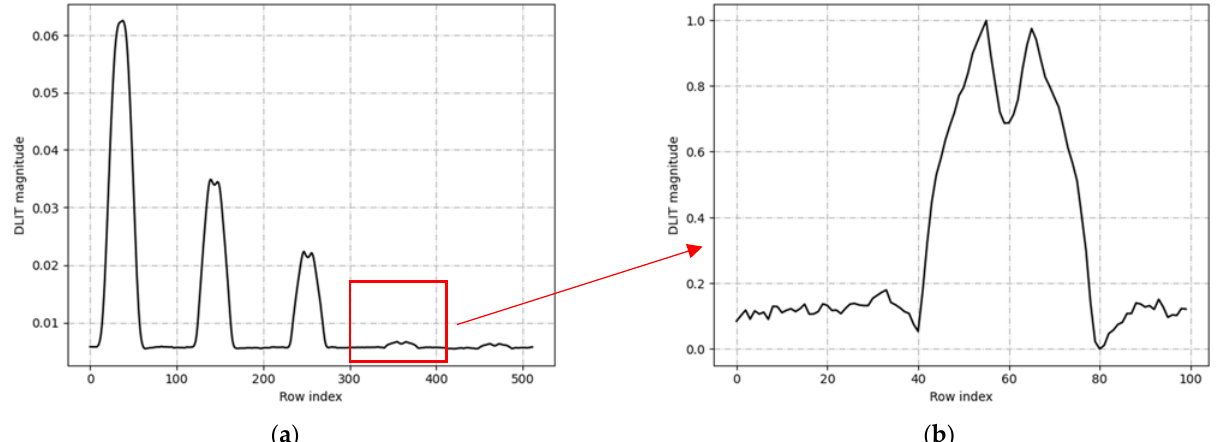
Figure 16. Effectiveness of 0-1 scaler: ( a ) Intensity plot prior to scaler; ( b ) Scaled area within ROI of [300, 400].